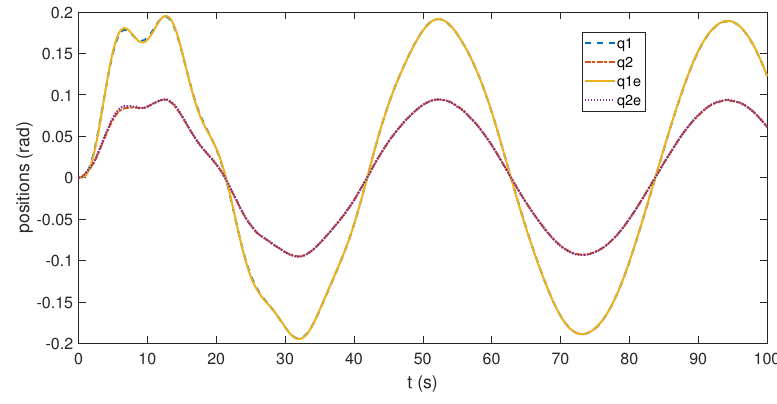
Figure 5. Position predictions under time-varying